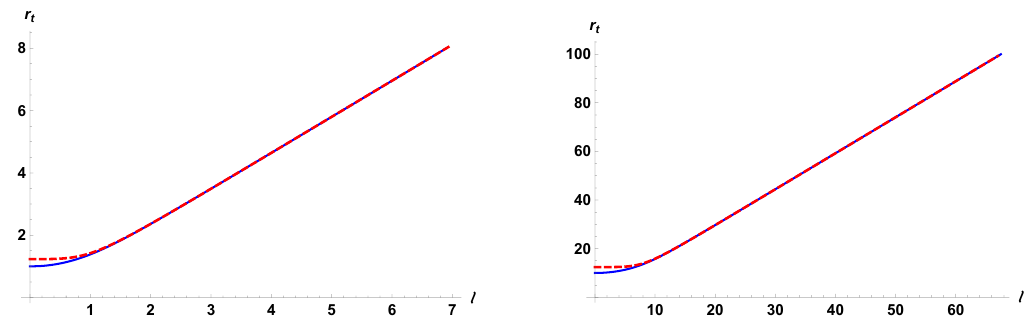
Figure 5 . The turning point r t as a function of ‘ for: Left ) r c = 1 and d e = 3 Right ) r c = 10 and d e = 4 . The solid blue curves are based on eq. (3.16), and the dashed red curves are based on the perturbative expression given in eq. (3.20) which is valid for very large entangling regions, ‘ (cid:29) r